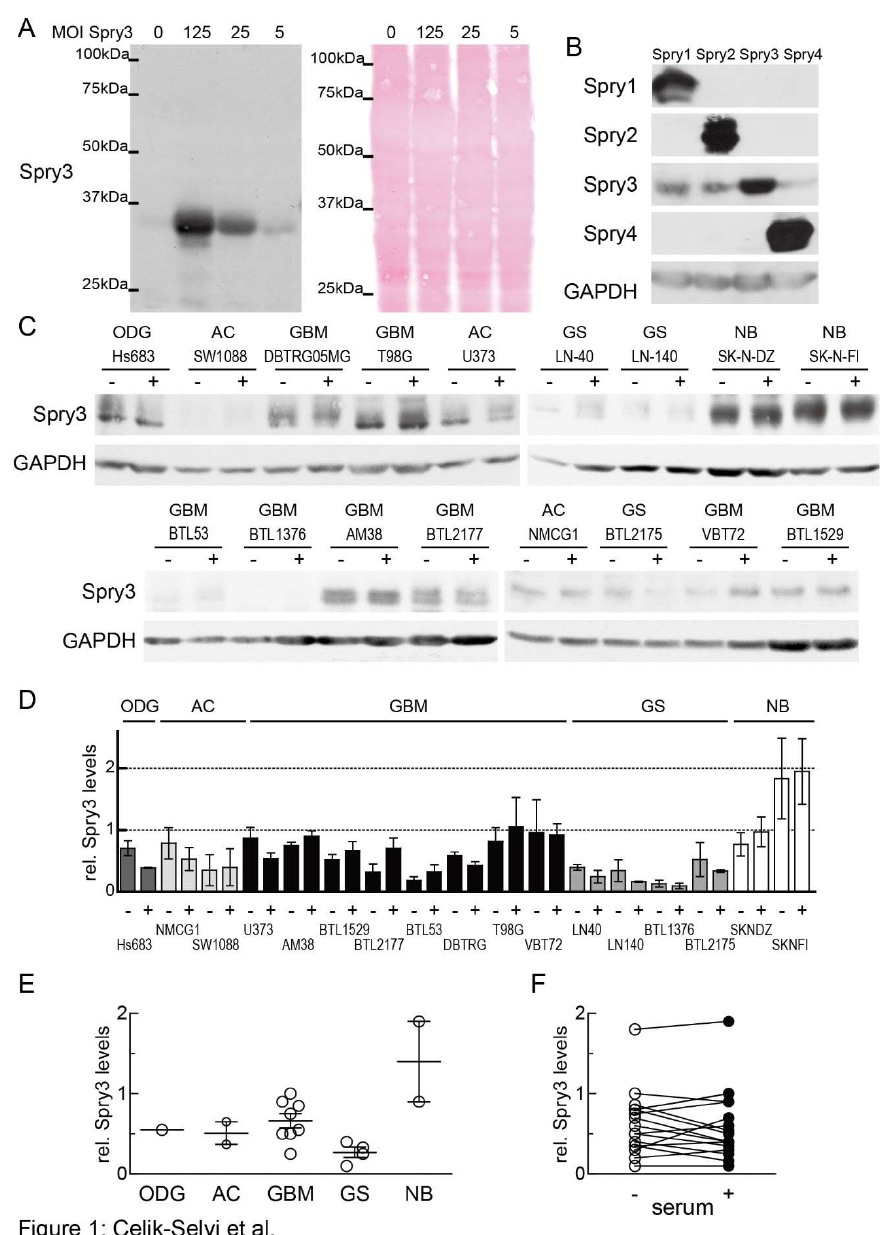
Figure 1. Expression of Spry3 protein in brain cancer-derived cell lines. ( A ) U373 cells were infected with decreasing amounts of adenoviruses expressing Spry3 protein and an immunoblot using Spry3 antibodies was performed. Equal loading was verified by Ponceau S staining of the immunoblot. ( B ) Adenoviruses expressing Spry1, Spry2, Spry3 or Spry4 were introduced into U373 cells. A total of 48 h post-infection cells were harvested and proteins were isolated. An immunoblot sequentially probed with all of the indicated antibodies is depicted. ( C ) Logarithmically growing cell lines derived from oligodendroglioma (ODG), astrocytoma (AC), glioblastoma (GBM), gliosarcoma (GS) and neuroblastoma (NB) were cultured for 24 h without (-) and with ( + ) serum. Using Western blot, endogenous Spry3 and GAPDH proteins were determined. ( D ) Amounts of Spry3 proteins were measured as ratio to an external control (MG63) by Image Quant software and normalized to GAPDH. Quantification results of 2–3 Western blots depicted as mean ± SEM are shown in a column graph. Cell lines were sorted according to their histopathological origin. ( E ) A scatterplot presenting the Spry3 expression across the histopathological subgroups of brain cancer is shown. ( F ) Calculated Spry3 levels from cells grown in serum-deprived (open circle) and –supplemented (closed circle) mediums are